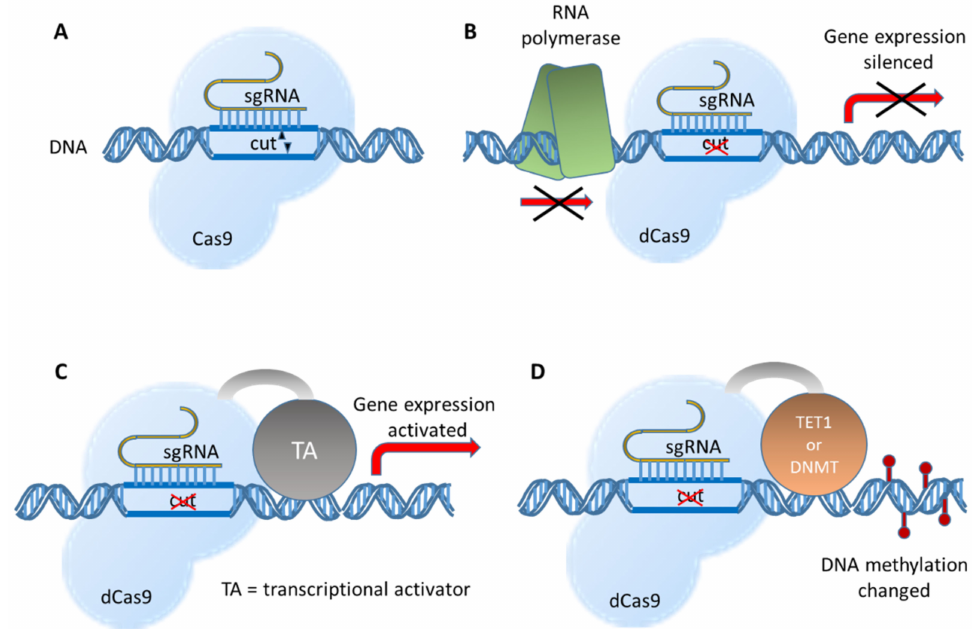
Figure 2. The basic CRISPR/Cas9 system and some examples of further developed fusion enzymes. ( A ) In its basic form, the CRISPR/Cas9 system introduces a double strand break close to the binding site of the sgRNA. ( B ) A mutated Cas9 protein without DNA cutting activity (dead Cas9 and dCas9) is still able to bind to DNA at the specific sgRNA-guided site and blocks the progression of the RNA polymerase, which results in the inhibition of transcription. ( C ) Fused to transcriptional activators, gene expression can be switched on or enhanced at targeted sites. ( D ) The dCas9 fused to histone modifiers or DNA methylation enzymes can be used to introduce site-specific epigenetic